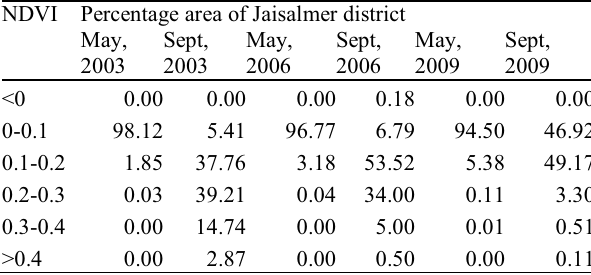
NDVI Percentage area of Jaisalmer district